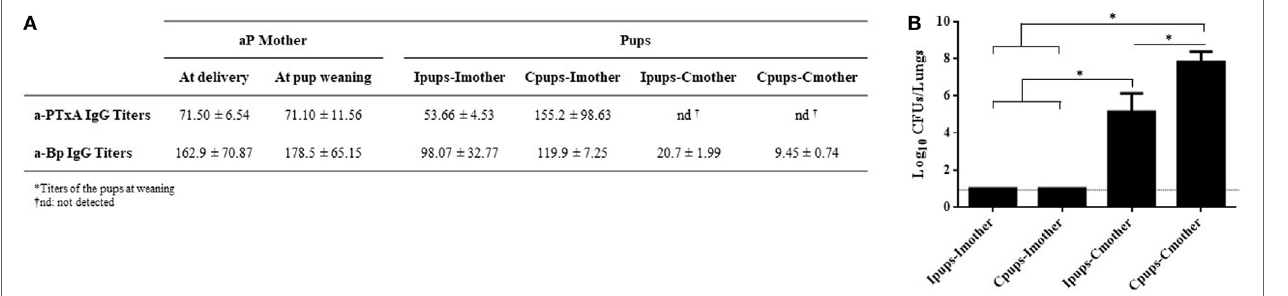
FigUre 5 | Effect of passive immunization through lactation on pertussis protection. Pups born from immune mothers (Ipups) were fostered to non-immune mothers (Ipups–Cmother), and pups born from control mothers were fostered to immune mothers (Cpups–Imother). Ipups breast-fed by their immune mother (Ipups–Imother) and Cpups breast-fed by their non-immune mother (Cpups–Cmother) were used as the respective positive and negative controls. All the pups ( n = 6 for each group) were suckled for 21 days. (a) Sera from mothers and pups were collected at different time points to analyze the titers of anti-pertussis toxin (a-PTxA) and anti-whole-cell- B. pertussis (a-Bp) IgGs. The titers are expressed as the geometric mean of the data for each group ( n = 6). (B) Pups were challenged with a sublethal dose of Bordetella pertussis Tohama phase I to analyze protection. In the figure, the number of bacteria recovered from the mouse lungs, expressed as the log 10 (mean CFUs ± SD of per lungs), is plotted on the ordinate for each of the dam-suckling groups indicated on the abscissa . The dotted horizontal line marks the lower limit of detection. Two independent experiments were performed. * p < 0.05 for Ipups–Imother and Cpups–Imother versus the other groups and for Ipups–Cmother versus Cpups–Cmother.